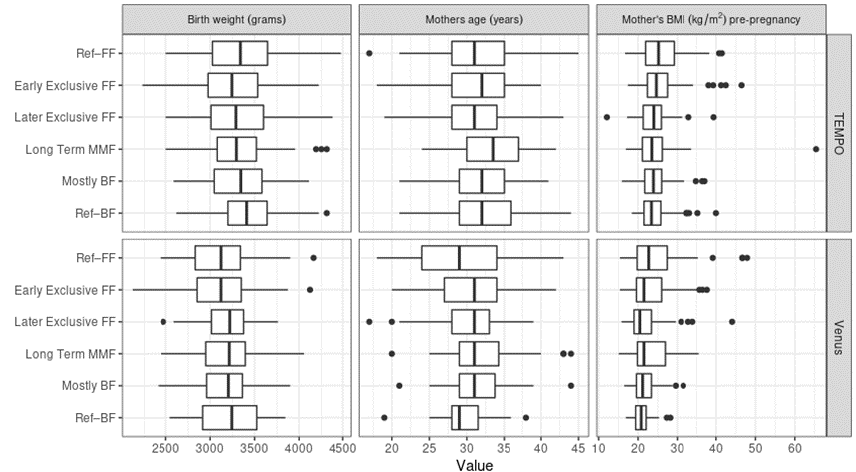
Figure 7. Similarities between birth weight, maternal age, and maternal body mass index (BMI) pre-pregnancy among the MMF Clusters. The three variables are shown for TEMPO (above) and Venus (below).